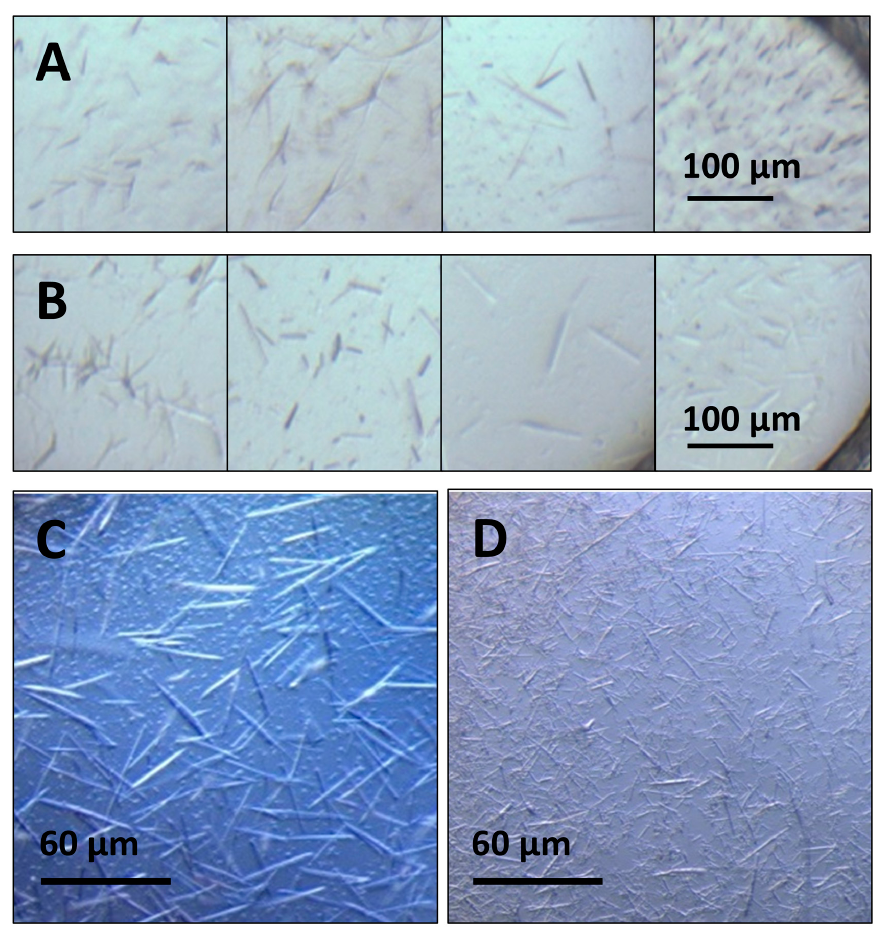
Figure 3. Hits generated by the HWI High throughput screen for ( A ) ApoA1 and ( B ) ApoE4 NLPs. Wells were imaged between 2 and 4 weeks after the experiment was initiated using a custom-built optical imaging system at 21 ◦ C. Rod / rod cluster or needle / needle cluster morphologies dominate hit conditions containing varying bu ff er and pH conditions, salt additives, and precipitants for both ApoA1 and ApoE4 NLPs. Hits reproduced and optimized for SFX at LLNL for ( C ) ApoA1 and ( D ) ApoE4. Conditions pictured are ( C ) S816-4 and ( D )